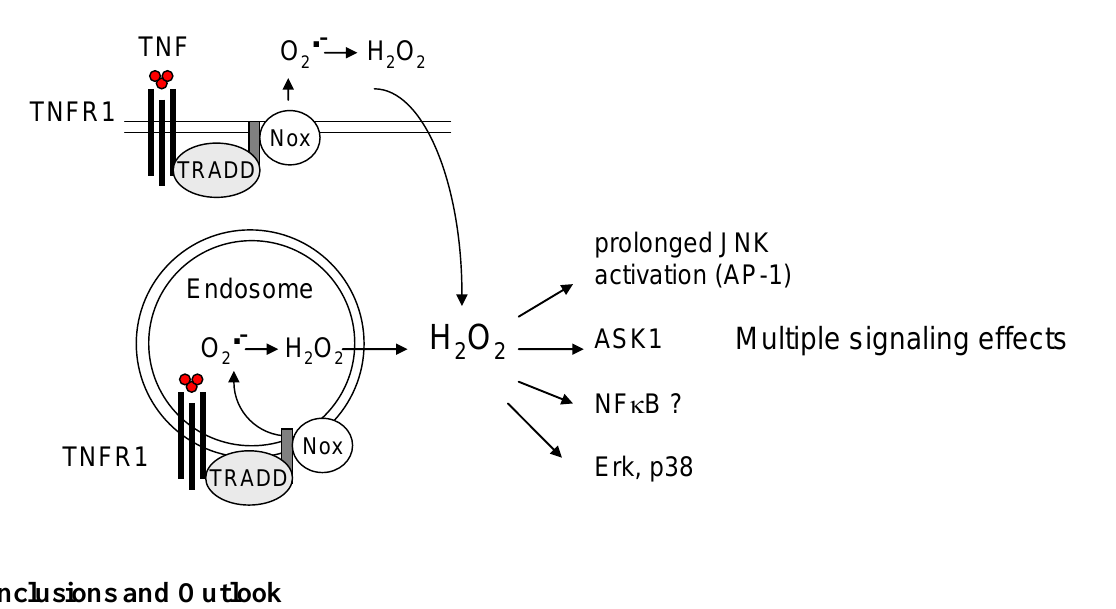
Figure 5. Role of endogenous ROS. Endogenous ROS are second messengers that are utilized by cytokine receptors, as for example tumor necrosis factor (TNF)  receptor 1 (TNFR1) (see text for explanation). The alternate ROS pathway, involving FAN and other signaling activities of TNFR1 are not shown in this illustration. TRADD, TNFR1- associated death domain protein; ASK1, apoptosis signal-regulating kinase